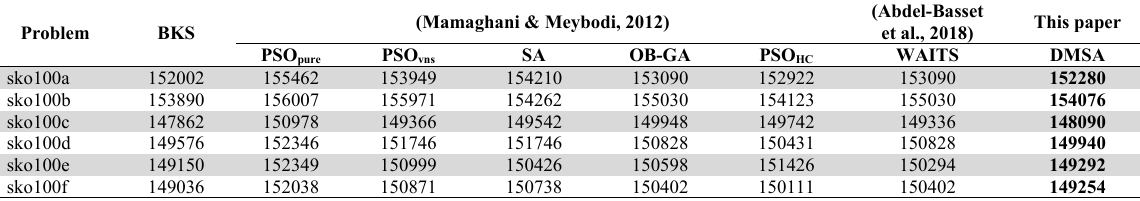
A comparison of the performances of different methods on sko100a-f Problem